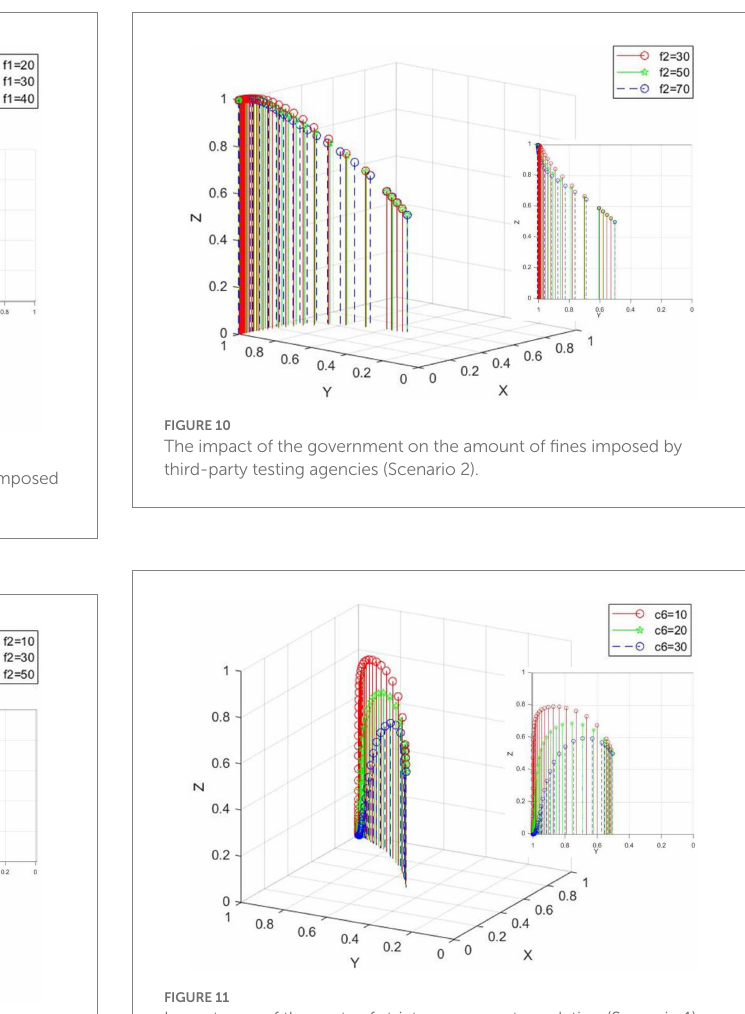
FIGURE 9 The impact of the government on the amount of fines imposed by third-party testing agencies (Scenario 1).